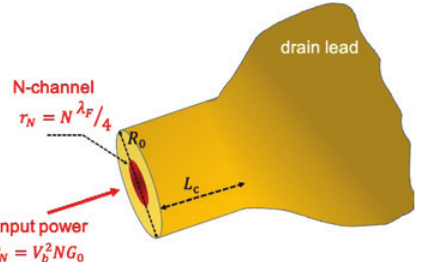
Figure 4: Sketch representing the constriction and the different characteristic parameters used in the